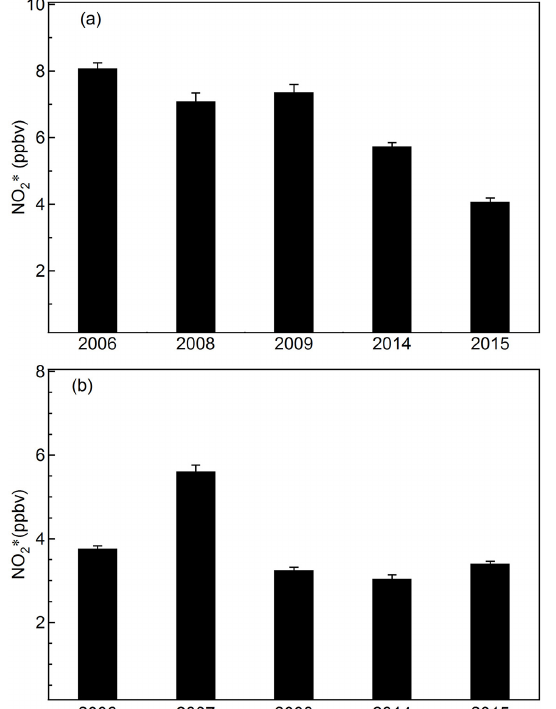
concentrations measured at 2 . 2